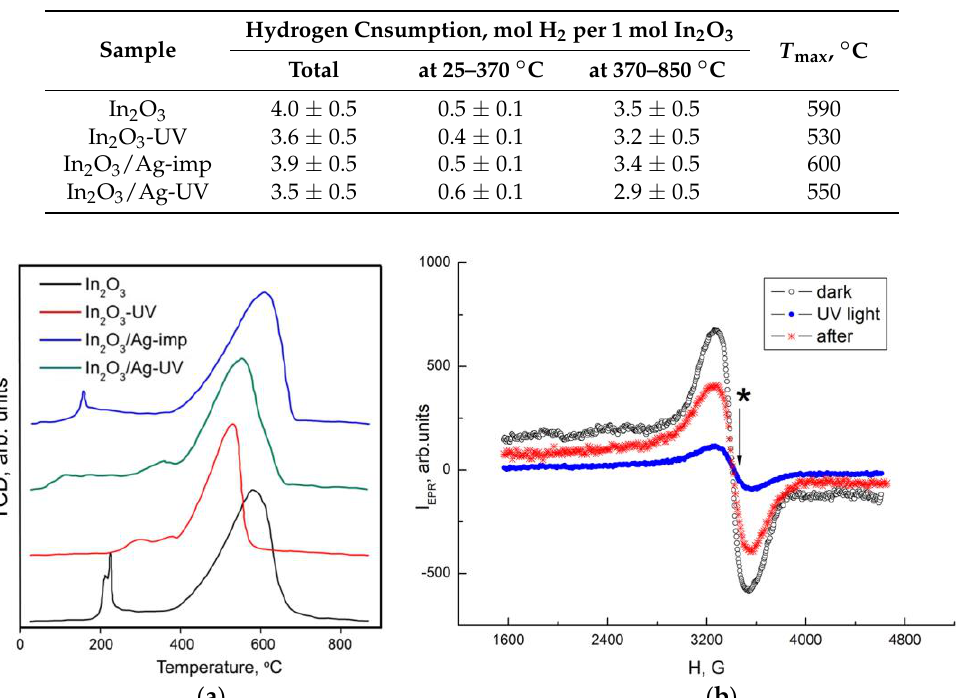
Table 2. The results of the TPR-H 2 experiments.